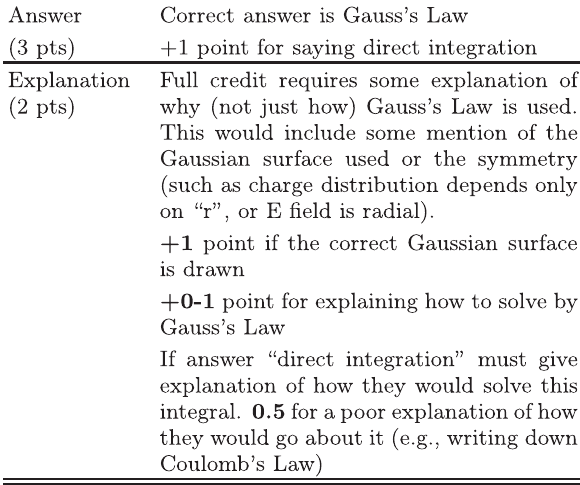
FIG. 2. An example question from the CUE along with the associated scoring rubric. This style of complex rubric was used for the CUE and QMAT and graders must undergo specific training to use these rubrics to produce reliable